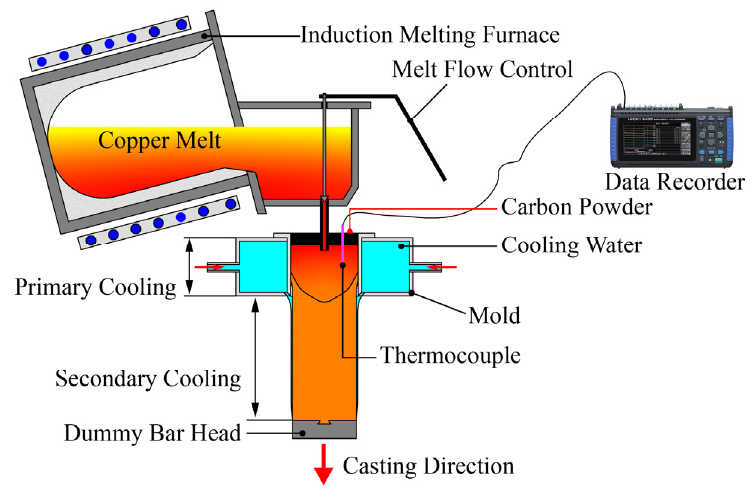
Figure 2. Schematic diagram of the experimental setup.